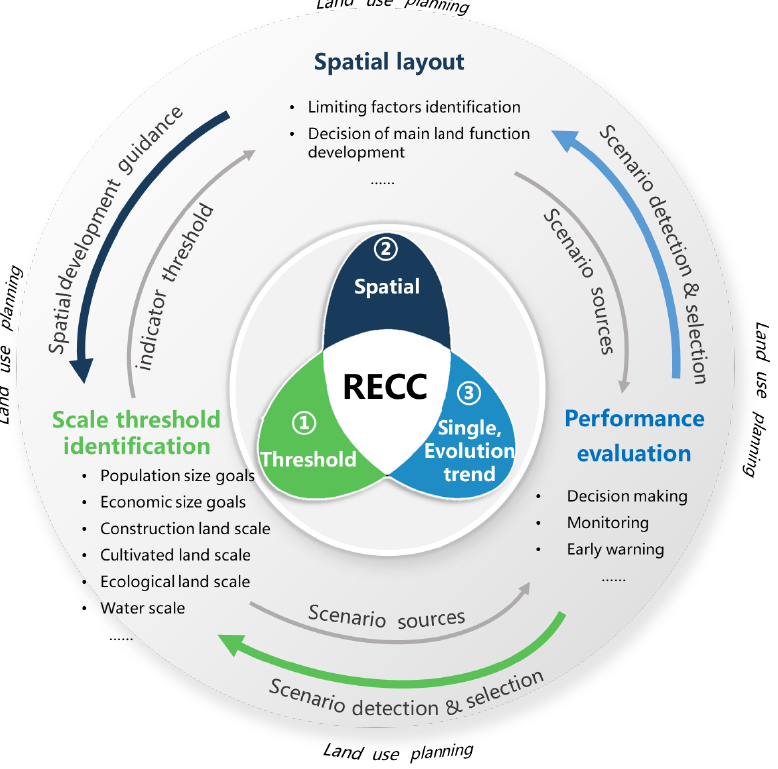
Figure 4. The pathways of RECC assessment as a tool of LUP.